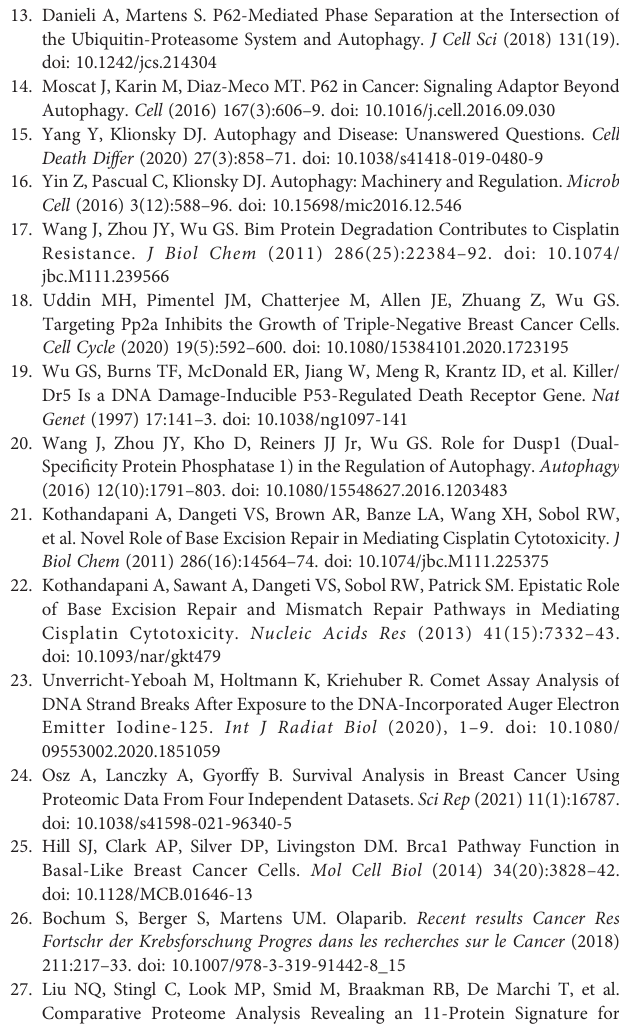
Supplementary Figure 1 | Effects of everolimus in combination with olaparib in the growth of olaparib-sensitive and olaparib-resistant SUM159 cells. A and B, Synergistic effects of everolimus and olaparib treatment on the growth of SUM159- P and SUM159-R cells respectively. Cells were treated with indicated drug combination for 72 hrs. Middle table, combination index (CI) values. Middle panel, graphical presentation of combination index along with the affected fraction (Fa). Right panel, normalized isobologram. Ola, olaparib; Eva, evarolimus. Supplementary Figure 2 | Effects of chloroquine in combination with olaparib in the growth of olaparib-sensitive and olaparib-resistant SUM159 cells. A and B, SynergisticeffectsofchloroquineandolaparibtreatmentonthegrowthofSUM159- P and SUM159-R cells respectively. Cells were treated with indicated drug combination for 72 hrs. Middle table, combination index (CI) values. Middle panel, graphical presentation of combination index along with the affected fraction (Fa). Right panel, normalized isobologram. Ola, olaparib; Chq,